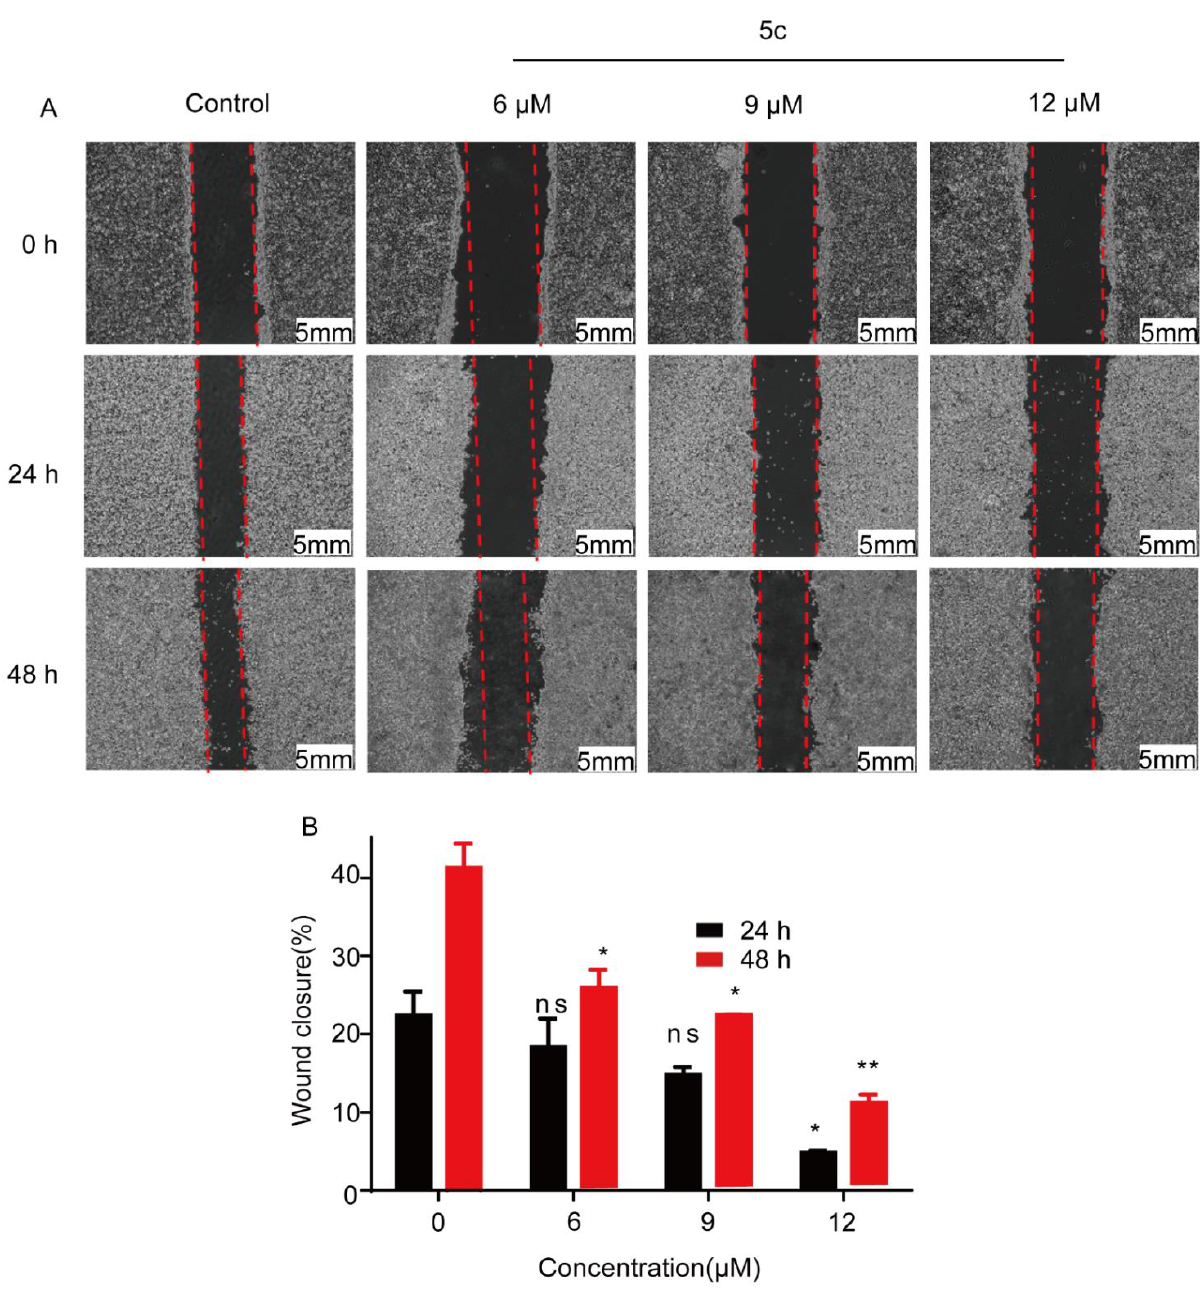
Figure 4. Compound 5c inhibited the migration of HeLa cells. ( A ) Wound healing assay. HeLa cells were cultured in a 6-well plate (1 × 10 6 /well) and scratched in the middle of each well with a 200 μL plastic pipette tip to create a mechanical wound. Then, the culture medium was changed to a fresh medium with different concentrations of compound 5c . Images were taken 0 h, 24 h, and 48 h after the scraping using a phase-contrast microscope. ( B ) The wound closure (%) was quantified by comparing the widths of the wound at 0 h, 24 h, and 48 h for each well. Values are presented as the means ± SDs from three independent experiments. ns = not significant, * p < 0.05, ** p < 0.01,